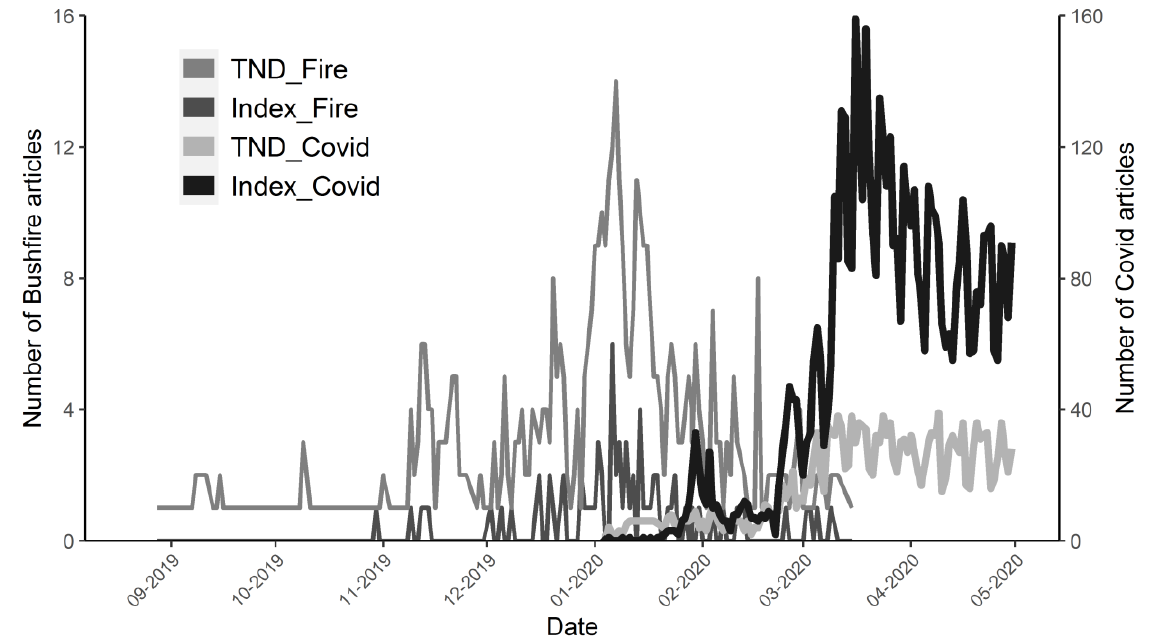
Figure 1. Daily number of articles: bushfire and COVID-19 pandemic.